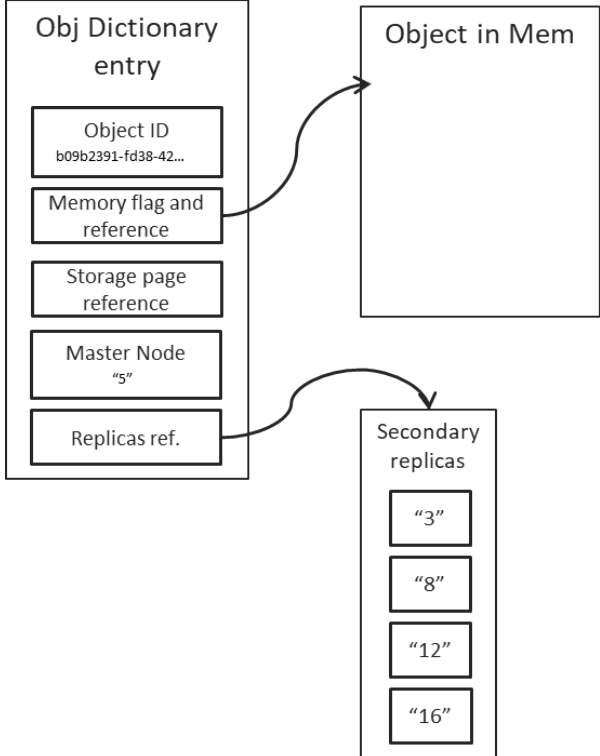
Figure 9. Structure of an Object Dictionary